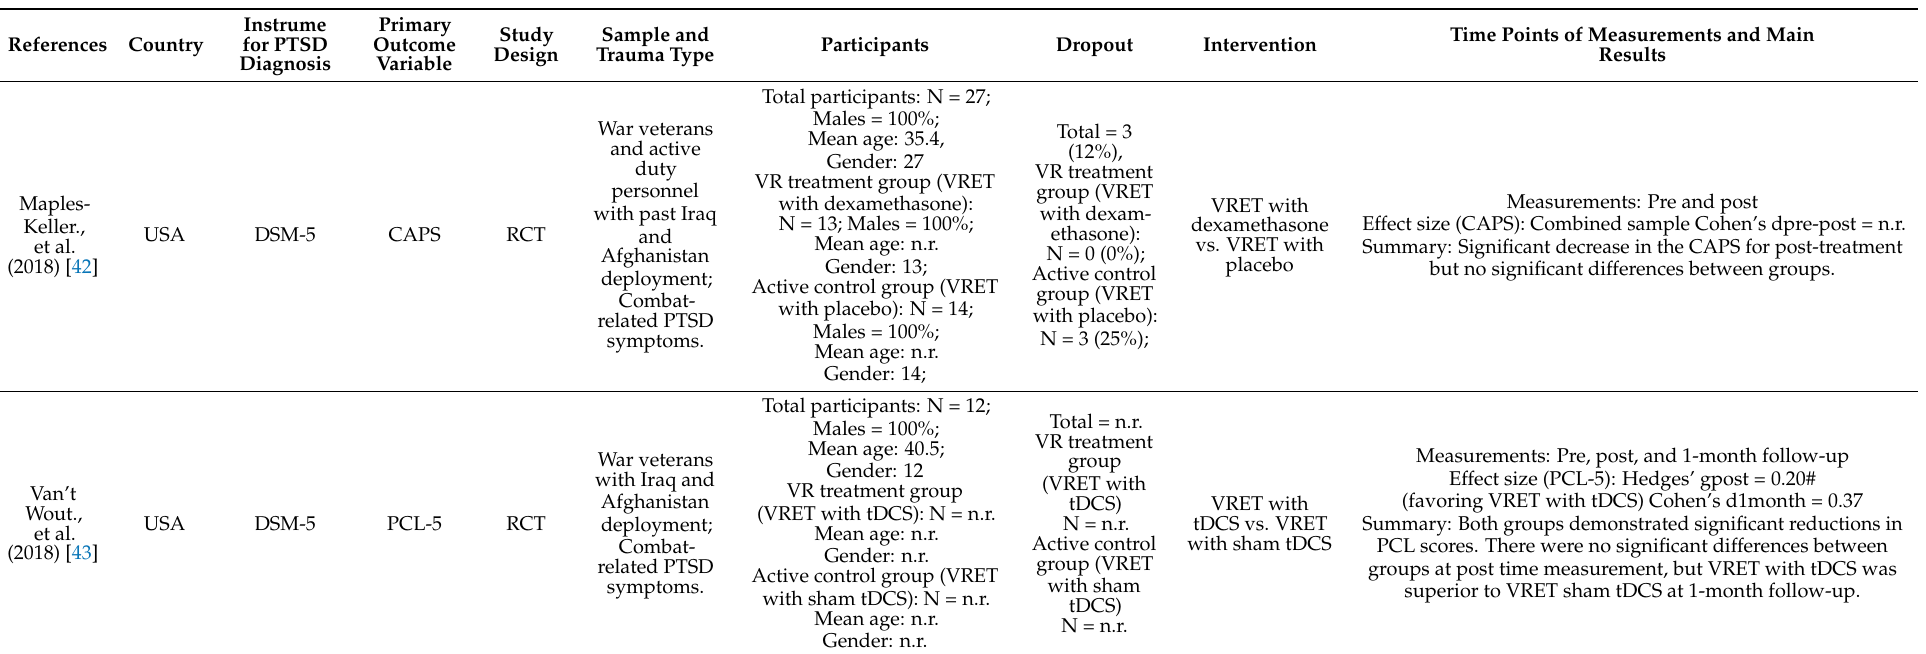
Dropout Intervention Time Points of Measurements and Main